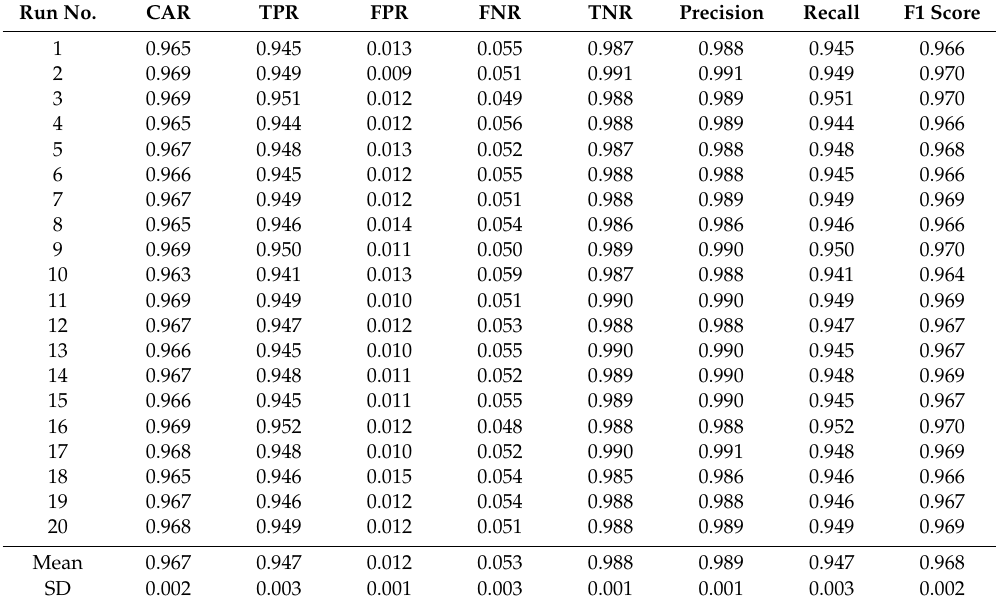
Table 1. Training performance of the RFM